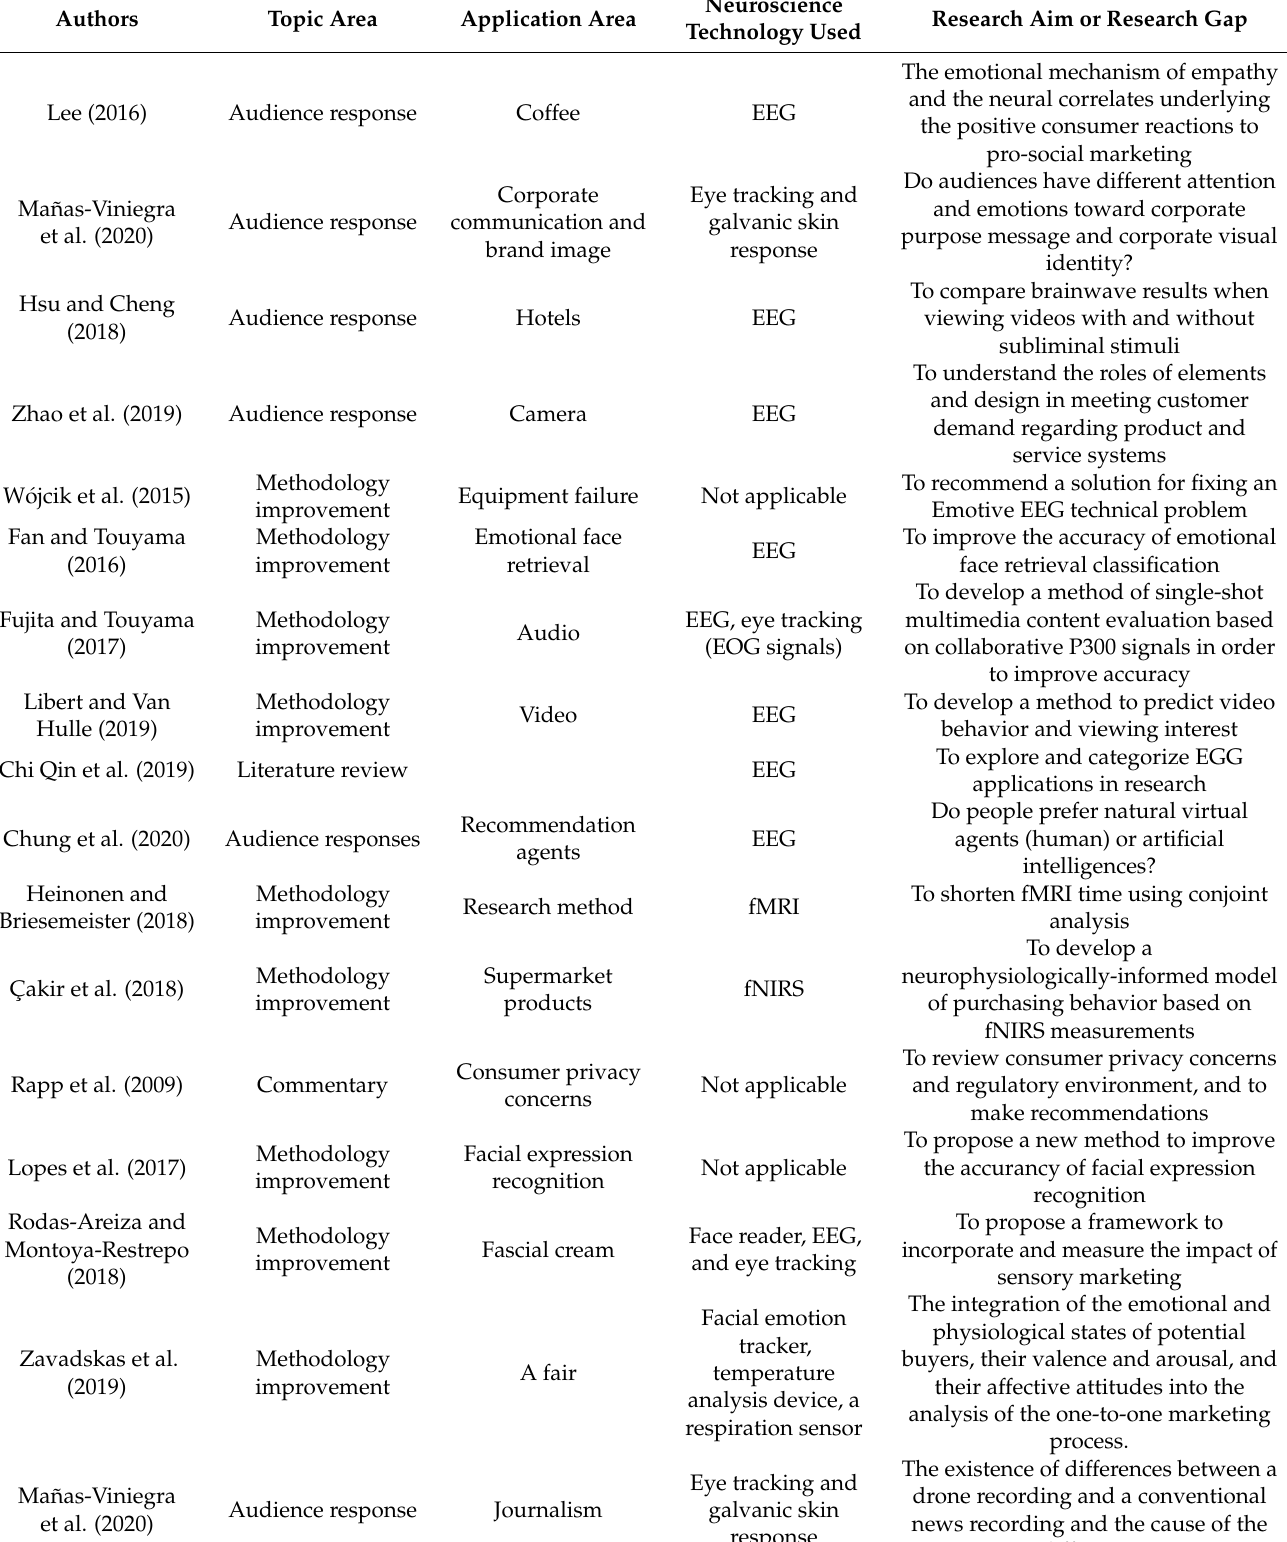
Table 9. Articles within the top ten Scival topics by best percentile: topic area, application area, neuroscience technology, and research